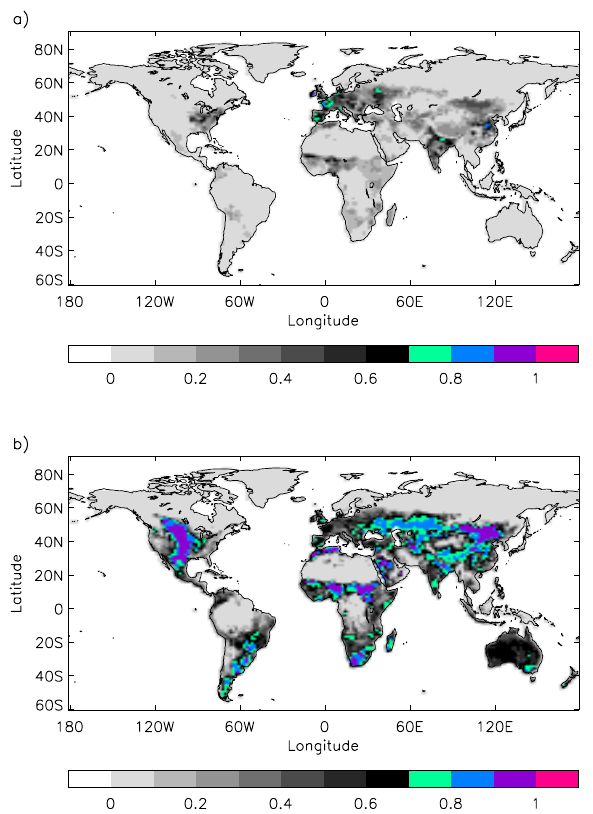
Fig. 12. Historical land use presented as fractional anthropogenic disturbance at (a) 1860 and (b)